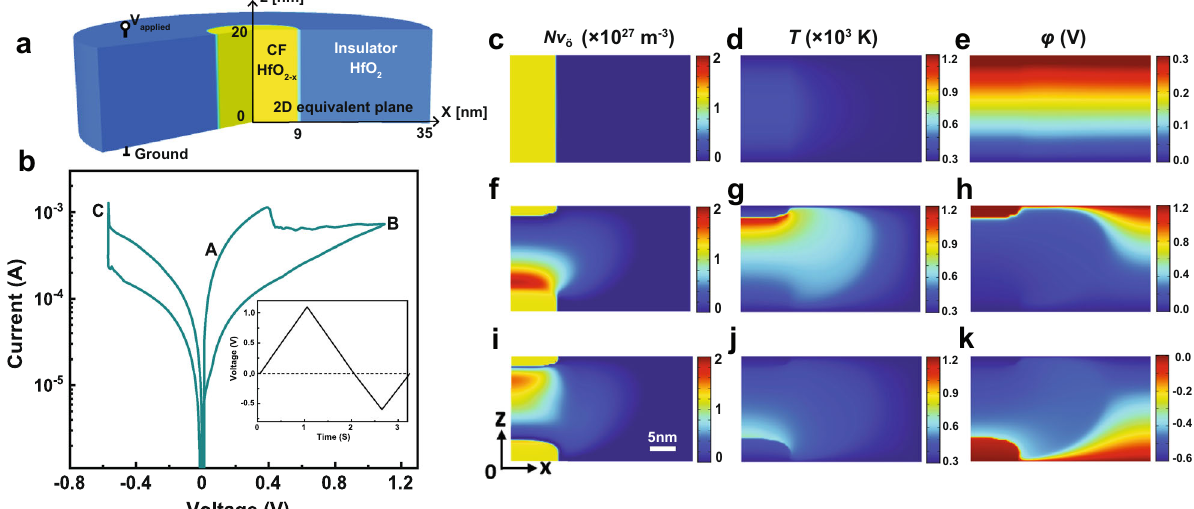
Fig. 1 Phase- fi eld simulation of resistive switching dynamics in HfO 2 metal oxide. a Simulation size and geometry. b Current – voltage ( I – V ) hysteresis behavior. The inset in b shows the applied triangular voltage sweep with rate dV / dt = 0.1 V/s. The simulated 2D spatial pro fi les of N V , T and φ at different applied voltages on top electrode: c – e V app = 0.3 V initial state; f – h V app = 1.1 V reset state; and i – k V app = − 0.57 V set € O state, corresponding to state A, B, C in b , respectively. The scale bar in i applies to c – k